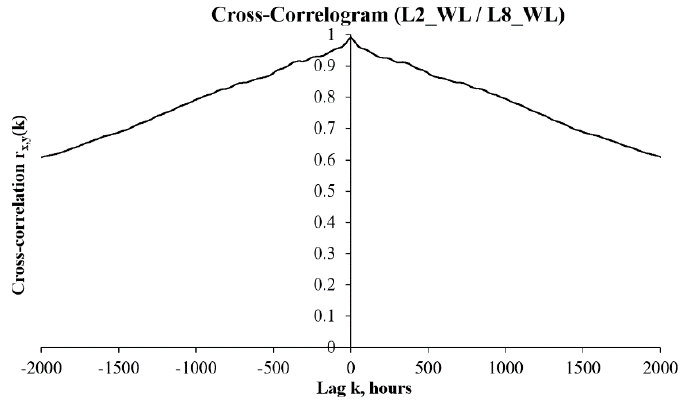
Figure 16. Cross-correlogram between the L2_WL and L8_WL data.